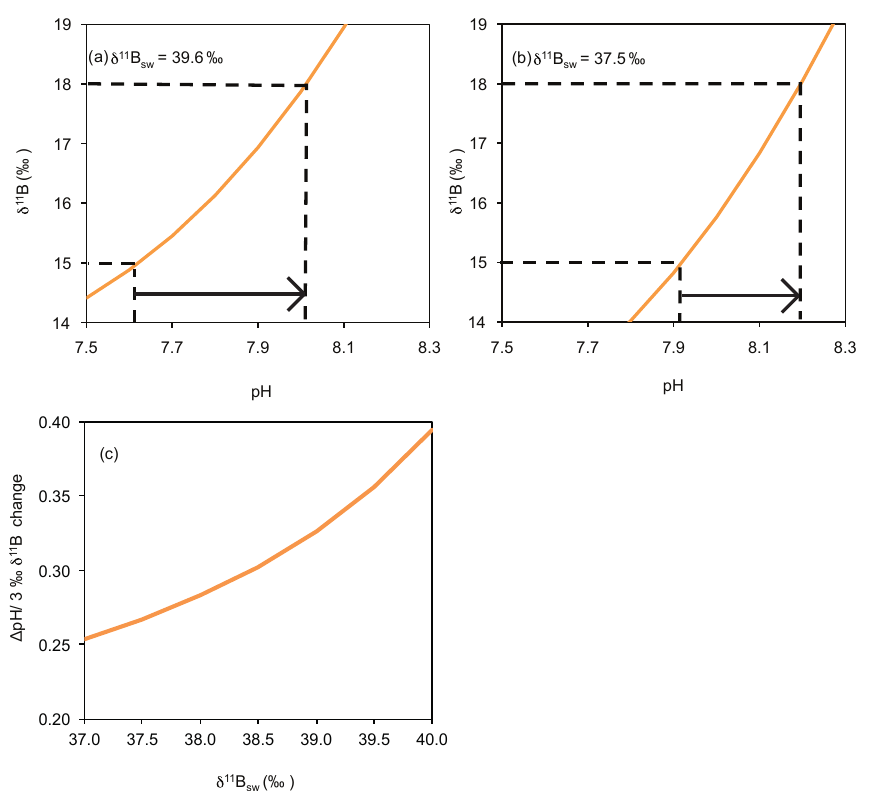
Figure 3. Schematic diagram showing the change in pH gradient with a 3‰ change in δ 11 B for δ 11 B sw of (a) 39.6 and (b) 37.5‰. Arrows highlight the different pH gradients. Note how a δ 11 B difference of 3‰ is translated into different pH gradients depending on the δ 11 B sw . Calculated using B T = 432.6µmolkg − 1 (Lee et al., 2010) and α B = 1.0272 (Klochko et al., 2006). (c) The pH change for a δ 11 B change of 3‰ at a range of different δ 11 B sw